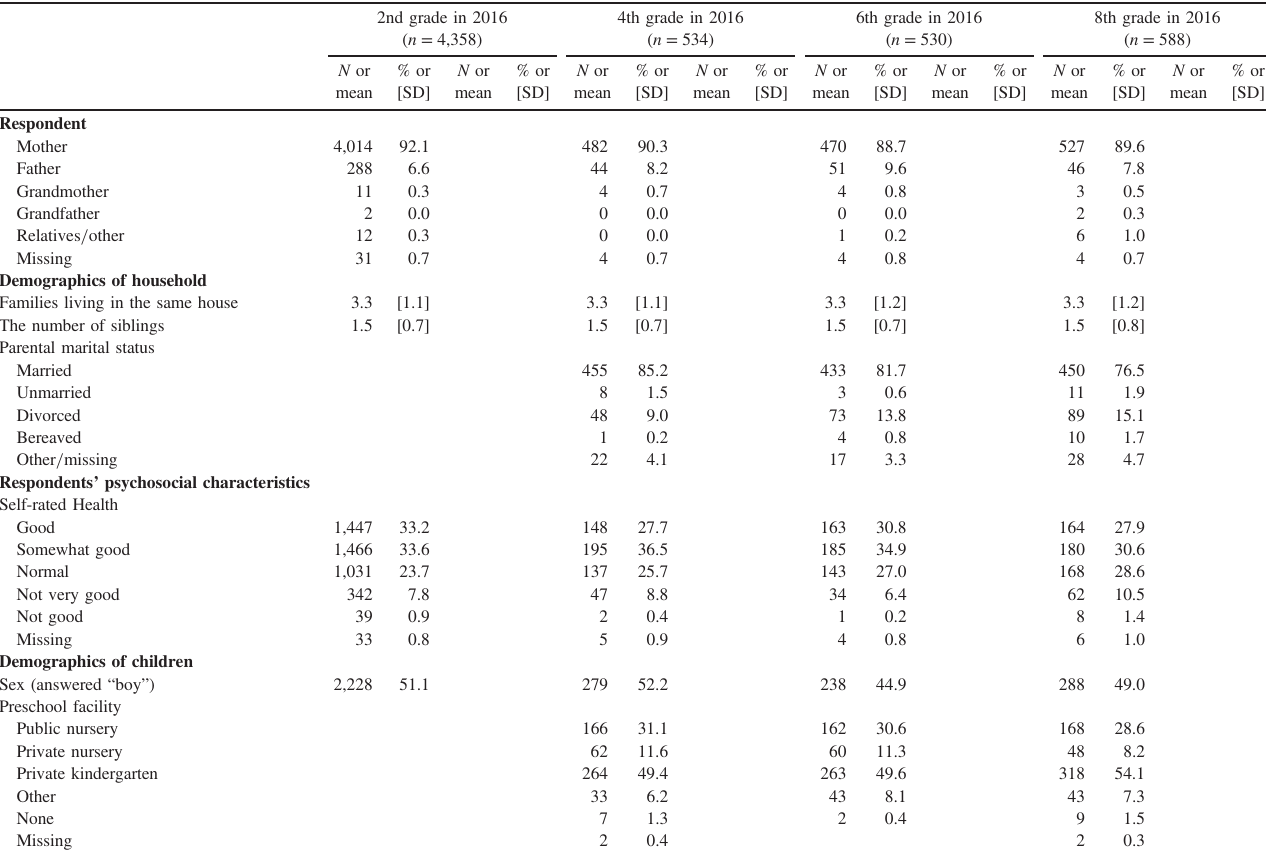
Table 6. Selected pro fi les of the participants for the 2nd wave of A-CHILD